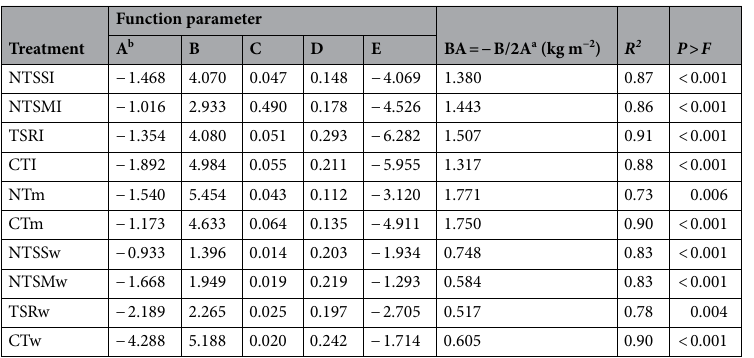
Table 3. Relationship between crop biomass accumulation (BA: kg m −2 ), soil temperature (T s ) and soil WFPS (W f ) and soil CO 2 fluxes in every cropping patterns: F s = A × BA 2 + B × BA + C × W f + D × T s + E. The data were adopted to fit into the function in 2014–2016. a The amount of biomass accumulation when soil CO 2 fluxes is maximal. b The capital letters are related parameters of function. c The descriptions of the treatment codes are given in Table